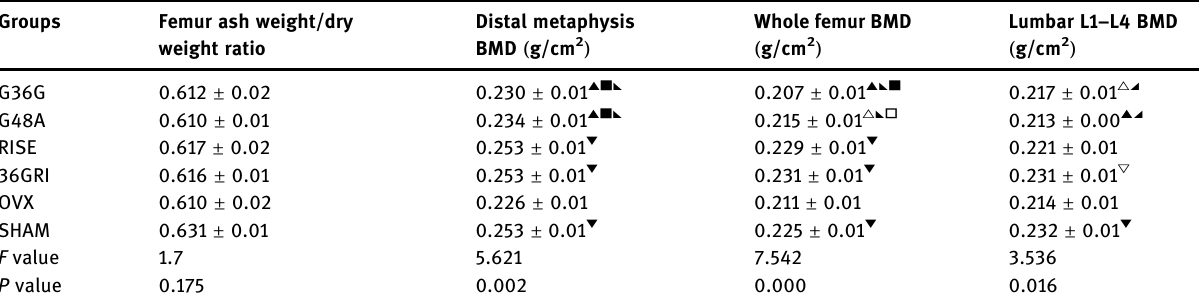
Table 3: E ff ects of di ff erent interventions on femur ash weight/dry weight ratio and BMD of whole femur, distal metaphysis, and lumbar L1 – 4 in rats ( x